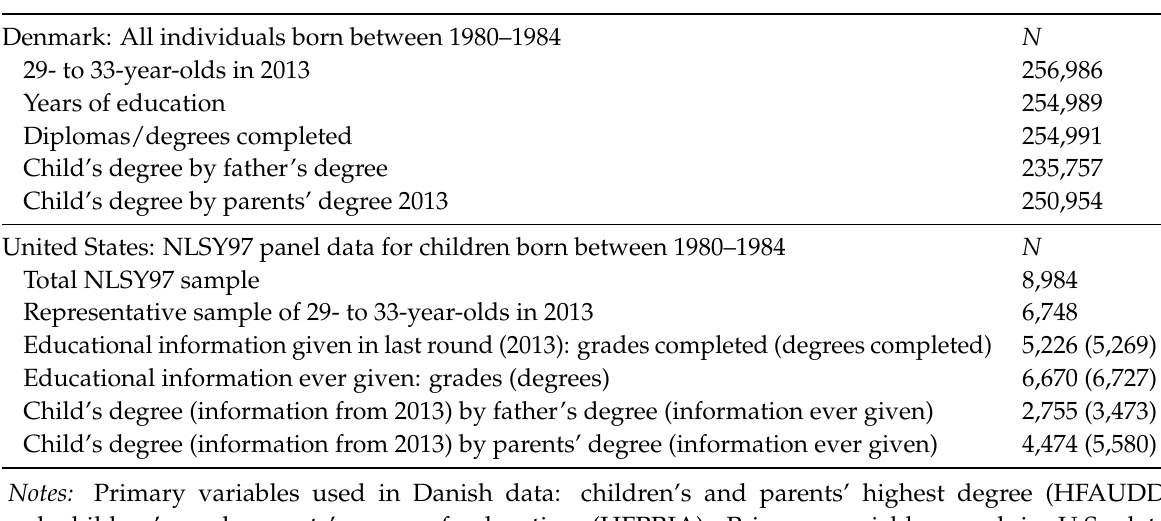
Table 3: Sample data and